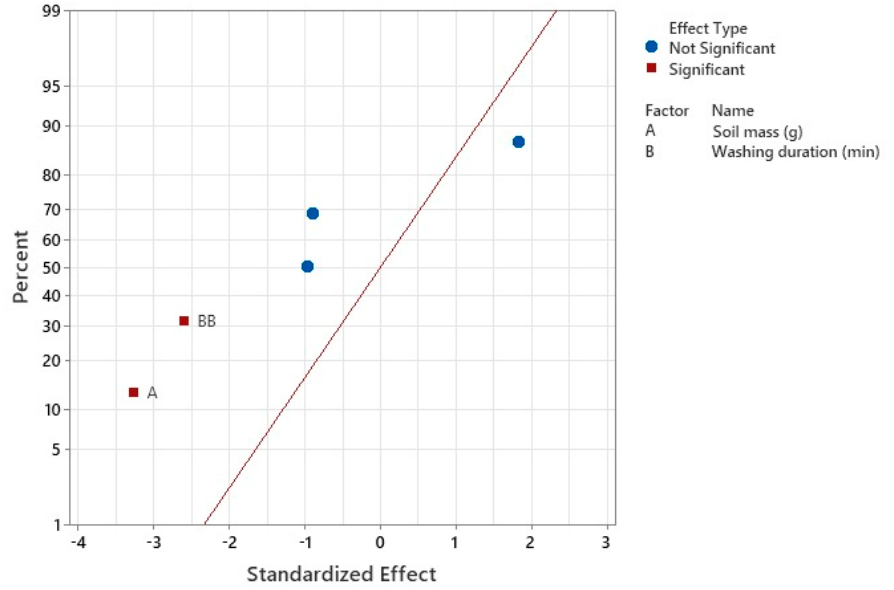
Figure 10. Normal plot of the standardized effects on oil removal (%); α (significance level) = 0.05.